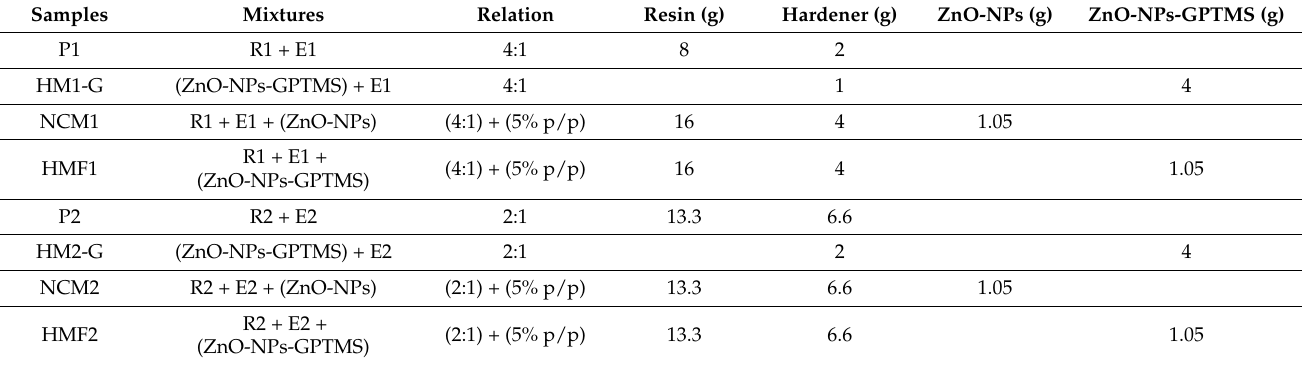
Table 2. Mixing relationships between resin, hardener, nanoparticles, and functionalized nanoparti- cles, for obtaining cured resins, nanocomposites, and hybrid materials.